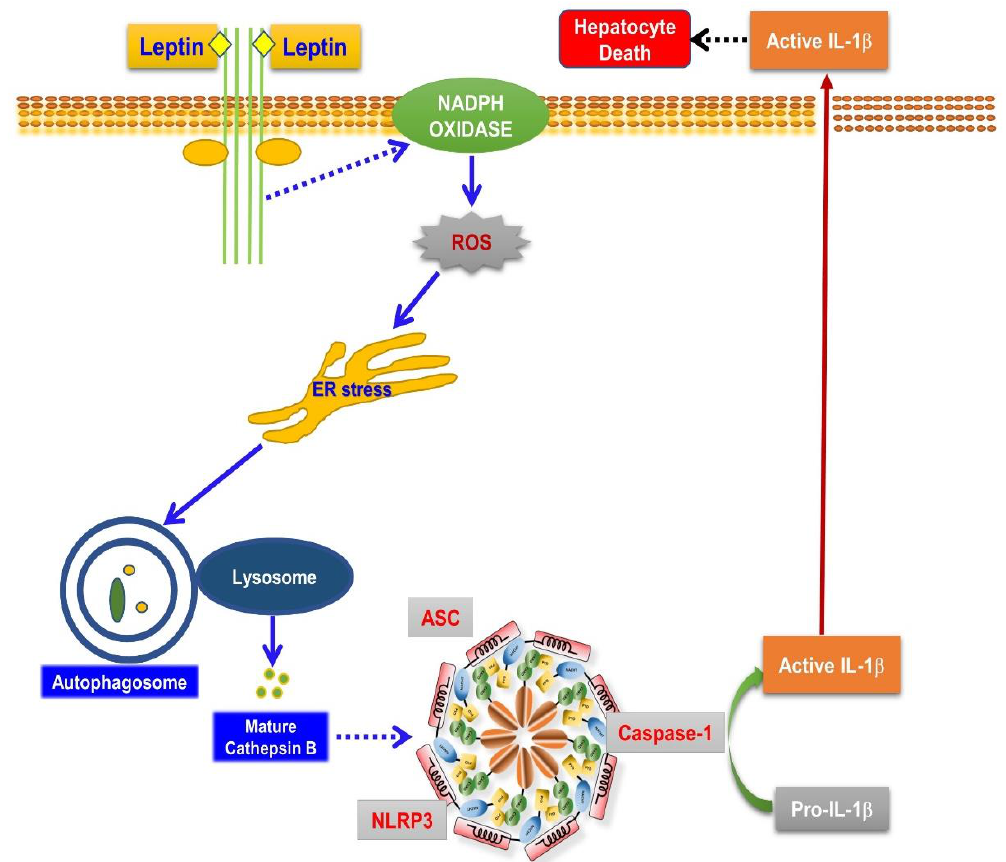
Figure 8. Proposed model for inflammasome activation by leptin and its role in hepatocyte death: Leptin induces apoptotic and pyroptotic cell death in rat hepatocytes. Cytotoxic effect of leptin in hepatocyte is mediated via activation of NLRP3 inflammasomes, which results in cleavage of caspase-1 and the maturation of IL-1 β . NLRP3 inflammasome activation by leptin is initially mediated via ROS production derived from NADPH oxidase. Enhanced intracellular ROS levels causes prolonged ER stress, which leads to autophagy induction and the further maturation of cathepsin B. Moreover, cathepsin B activation critically contributes to NLRP3 inflammasome activation, indicating that the ROS production/ER stress/autophagy induction/cathepsin B maturation axis is implicated in inflammasome activation by leptin in hepatocytes. Detailed molecular mechanisms by which active cathepsin B mediates inflammasome activation and IL-1 β signaling leading to apoptotic and pyroptotic cell death in hepatocytes remain to be further investigated.